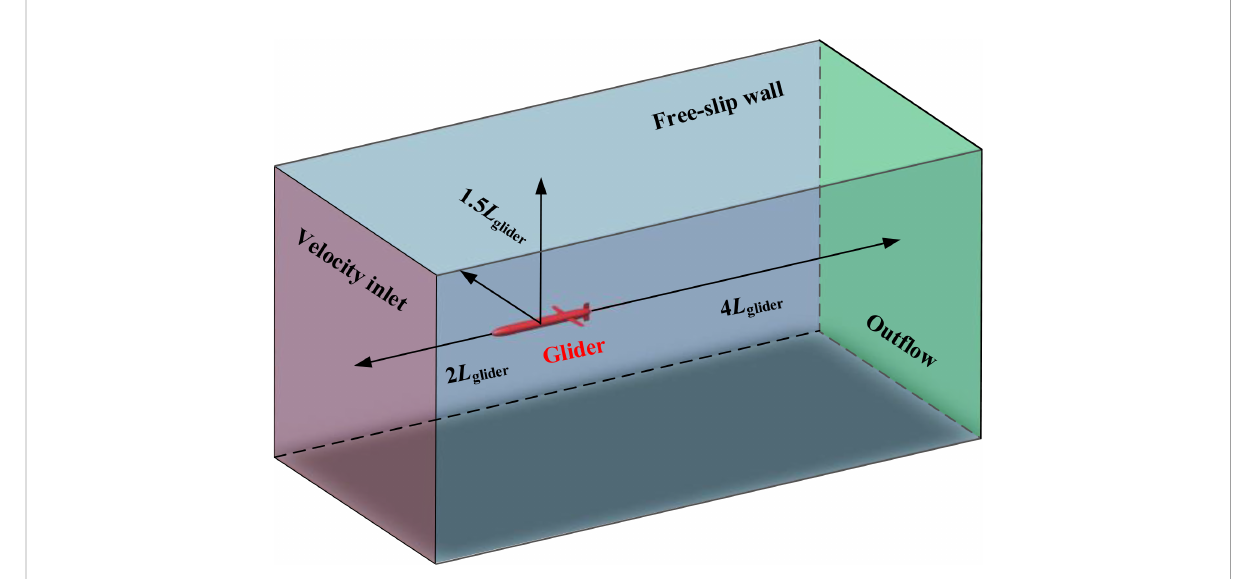
FIGURE 9 Boundary conditions of numerical simulation in fl ume experiment.